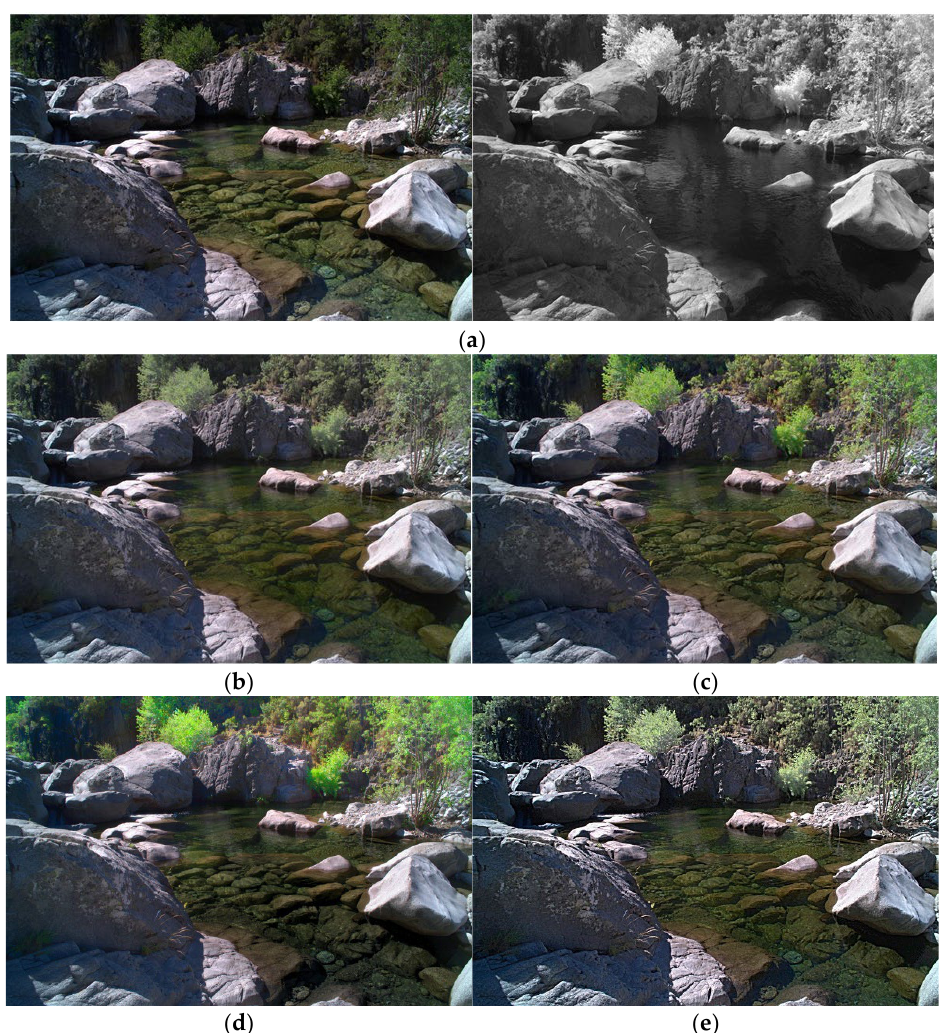
Figure 15. Daytime input and result images (3): ( a ) visible-light image and near-infrared image, ( b ) Densefuse method result, ( c ) Vanmali method result, ( d ) PCA method result, ( e ) proposed method result.